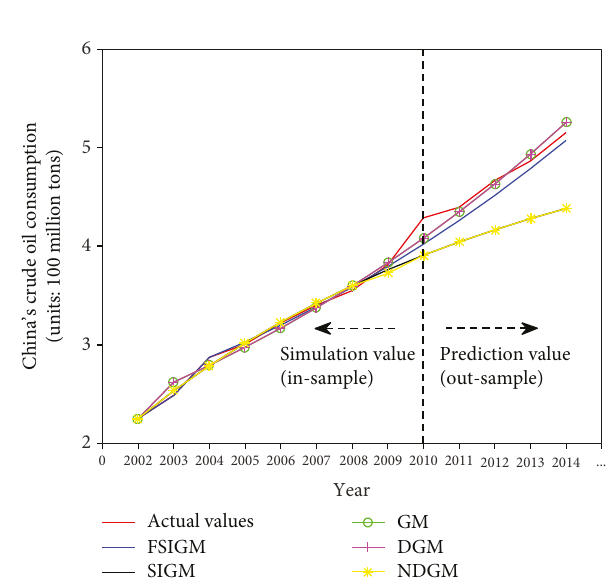
Figure 2: Simulation and prediction value of China ’ s crude consumption with two